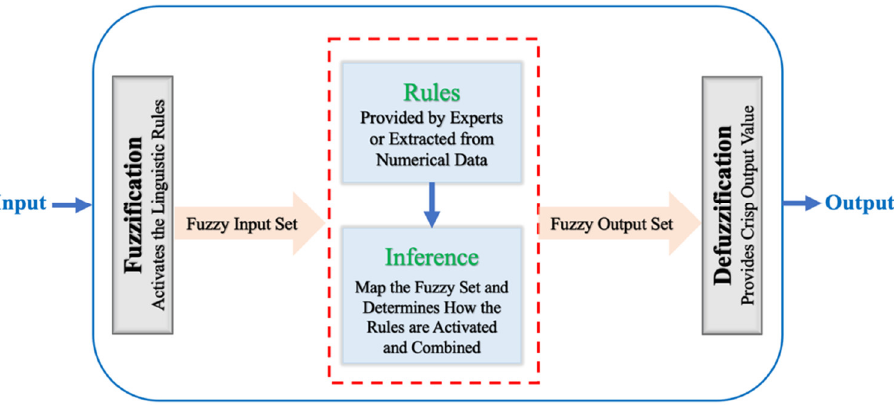
Figure 3. Simple FIS flowchart. Reprinted with permission from reference [42] Copyright 2012, Elsevier. 2012,